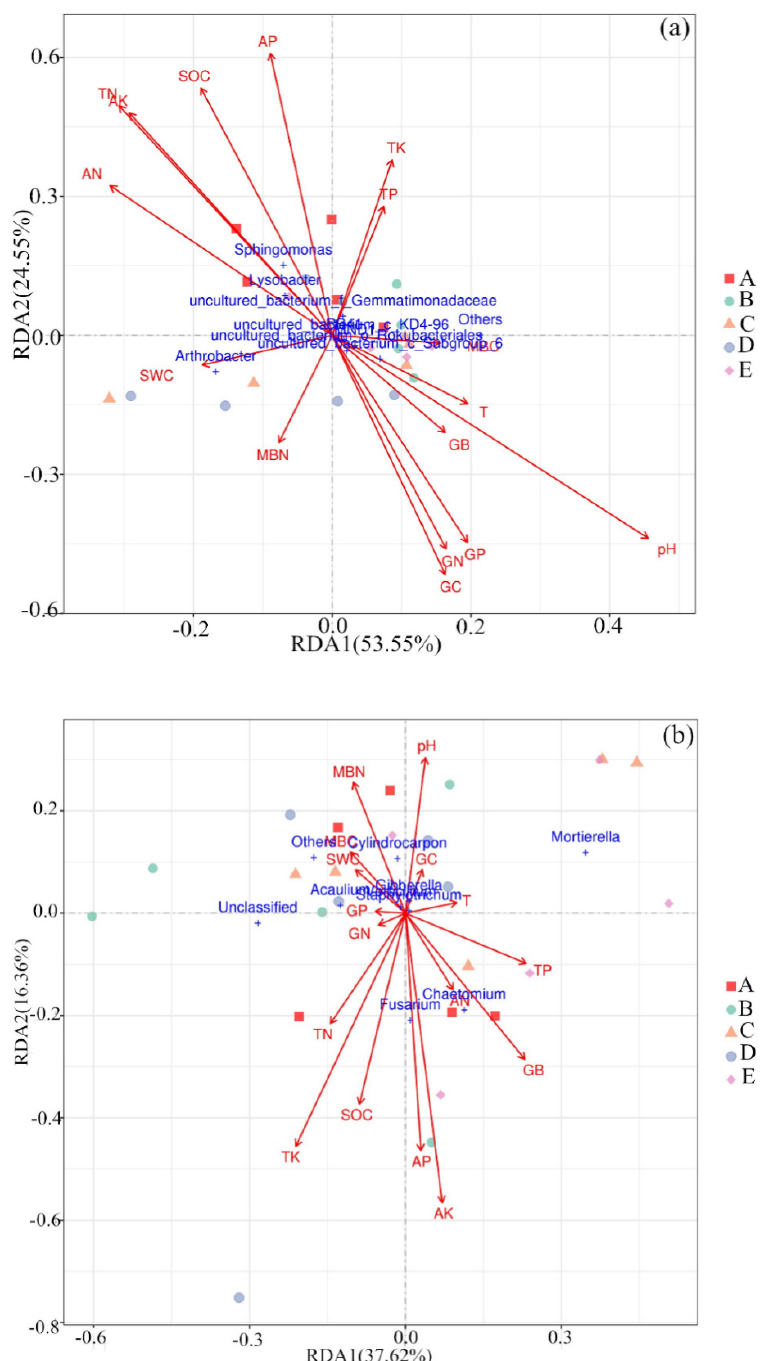
Figure 3. Redundancy analysis (RDA) of the relationships between soil and cover grass properties and microbial commu- nities. T indicates soil temperature, SWC indicates soil water content, SOC indicates soil organic carbon, AN indicates available nitrogen, TN indicates total nitrogen, TP indicates total phosphorus, AP indicates available phosphorus, AK indicates available potassium, TK indicates total potassium, MBC indicates microbial biomass carbon, MBC indicates mi- crobial biomass nitrogen, GB indicates cover grass biomass, GC indicates cover grass carbon, GN indicates cover grass nitrogen, and GP indicates cover grass phosphorus A indicates 0% (NC), B indicates 20% (LIC), C indicates 40% (MIC 1 ), D indicates 60% (MIC 2 ) and E indicates 80% (HIC). ( a ) indicates the bacterial community and ( b ) indicates the fungal com- munity.